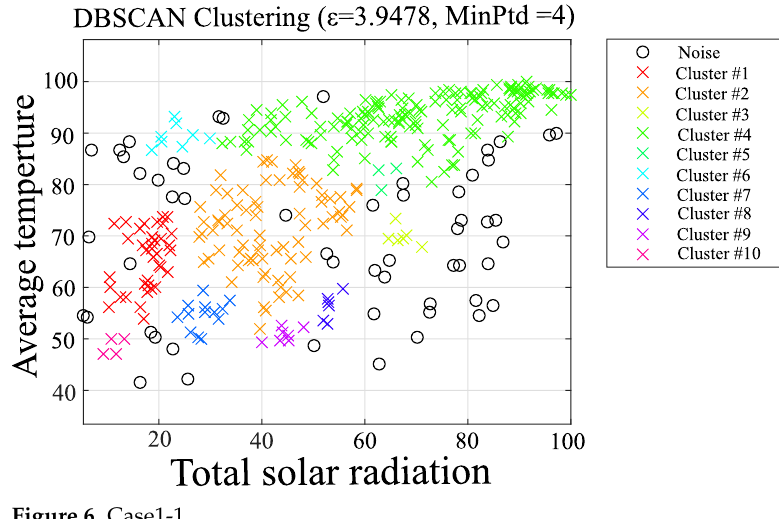
Figure 6. Case1-1.